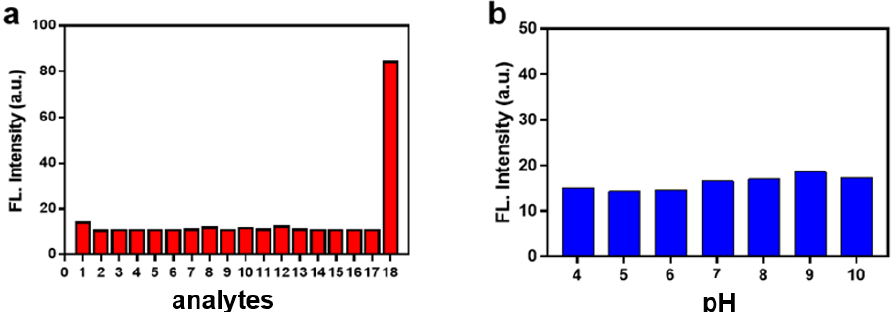
Figure 3. Fluorescence response of P2 (10 μ M) to various analytes and ( a ) different pH conditions ( b ). Groups were set as follows: 1, blank; 2, NaCl (100 mM); 3, MgCl 2 (100 mM); 4, KCl (2.5 mM); 5, Tyr (1 mM); 6, GSH (1 mM); 7, His (1 mM); 8, Cys (1 mM); 9, Glu (1 mM); 10, Gly (1 mM); 11, Arg (1 mM); 12, NaOH (100 µ M); 13, NaCO 3 (100 µ M); 14, Na 2 SO 4 (100 µ M); 15, NaNO 2 (100 µ M); 16, NaClO (100 µ M); 17, NaCl (100 µ M); 18, H 2 O 2 (100 µ M). Incubation time: 10